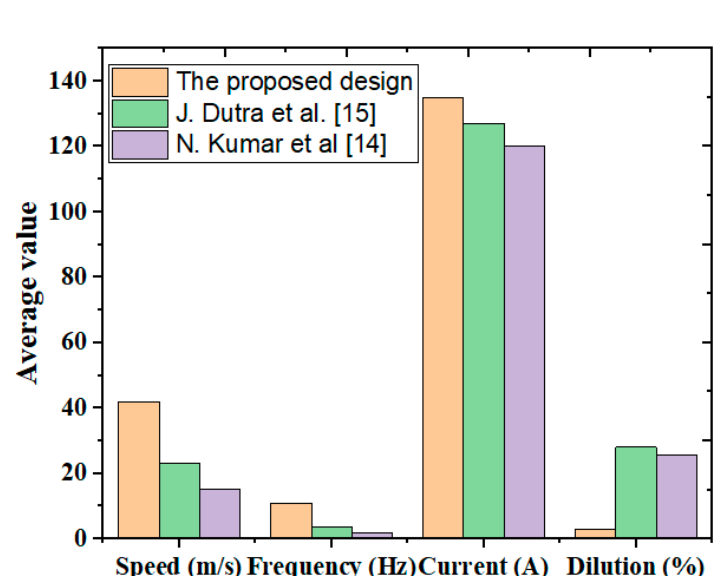
Figure 11. The comparison between the proposed design and previously published designs.